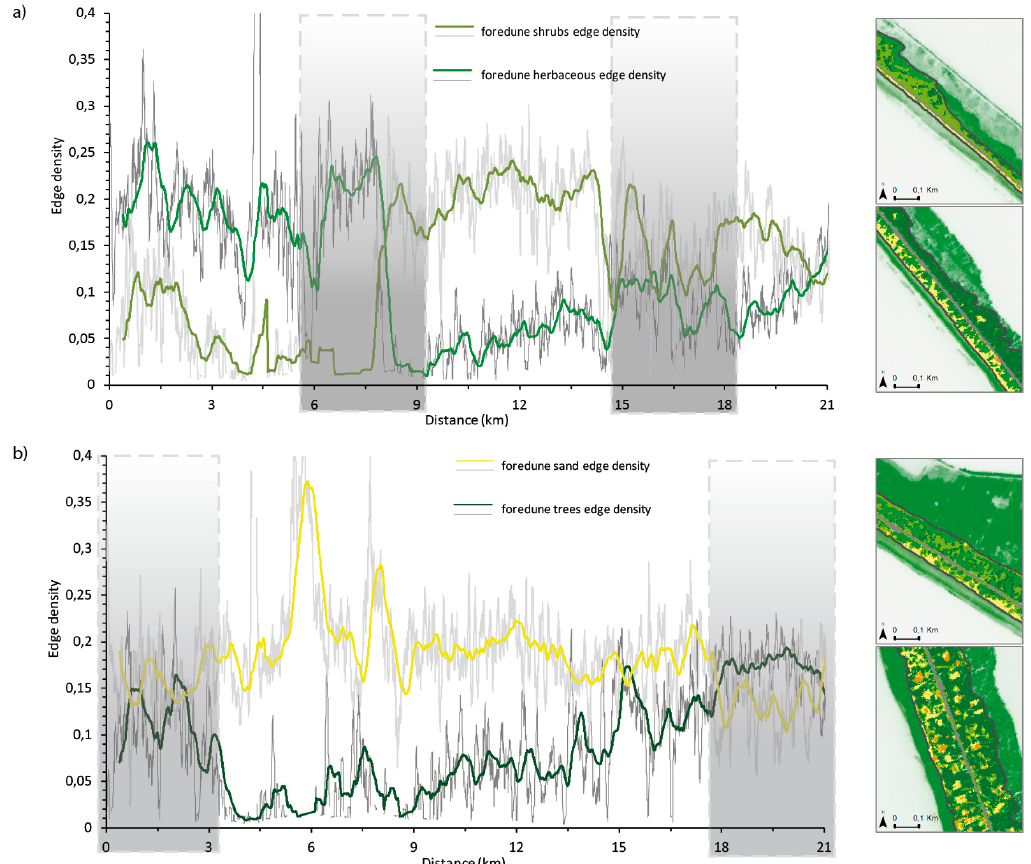
Figure 10. ( a ) Foredune herbaceous and shrubs edge density values: Two main changes in trend are detectable at 7.5 and 14.5 km. ( b ) Foredune sand and trees edge density values: Reversed trend between 0 and 2.5 km and after 15 km. Gray lines represent all the data points, and the colored bold lines, used to enhance the graphical view of each trend, are the moving averages of data points (average of 100 data points interval). On the right side, the miniatures show the dune cover map corresponding to the highlighted grey windows in the graphs (note that the orange color is the anthropic cover class not shown in the foredune edge density (ED) trends).